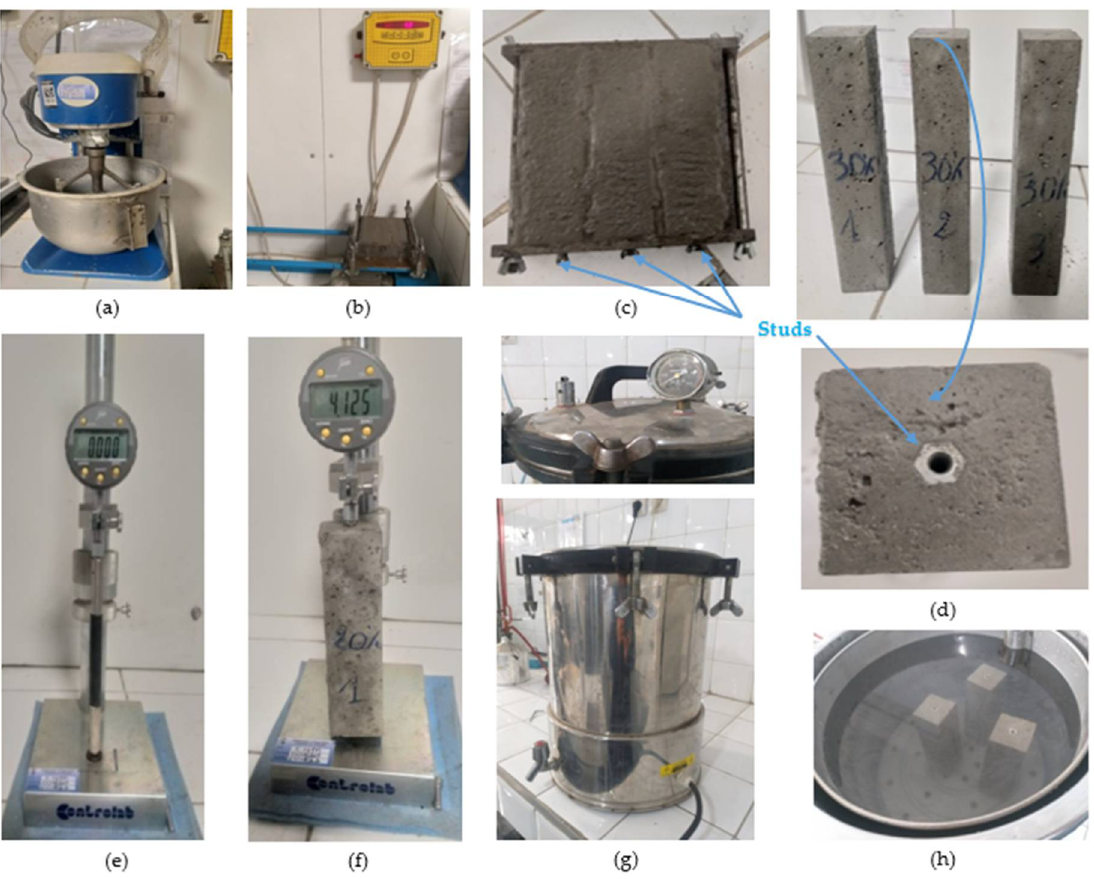
Figure 5. Experimental details of durability test against ASR: ( a ) mixer, ( b ) vibrating table, ( c ) prismatic molds, ( d ) samples after demolding operation, ( e ) numeric comparator with calibration bar, ( f ) measure of elaborated sample, ( g ) autoclave, and ( h ) samples after autoclave opening. Table 4. Formulation of each mortar-based composite for ASR test.